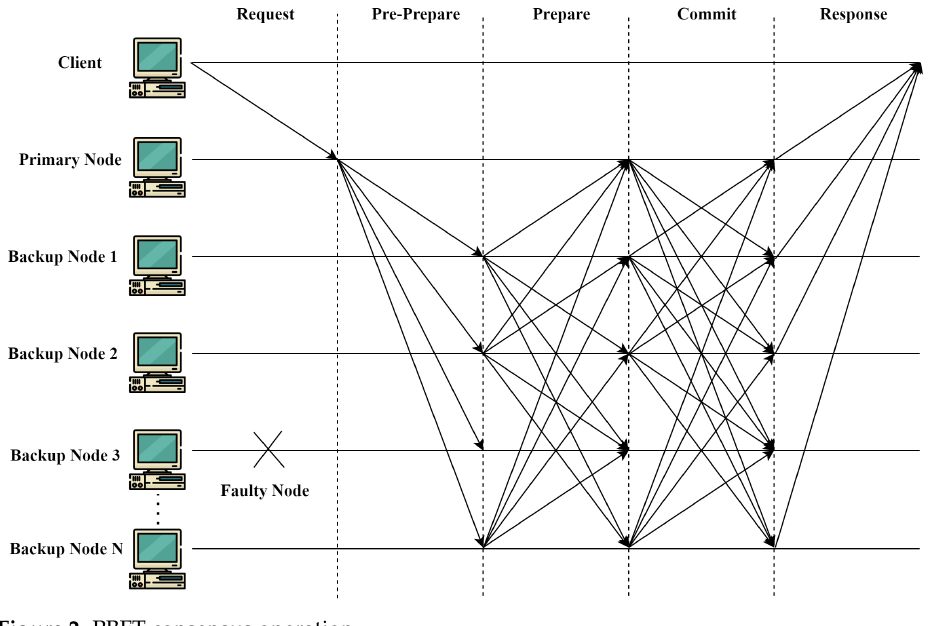
Figure 2. PBFT consensus